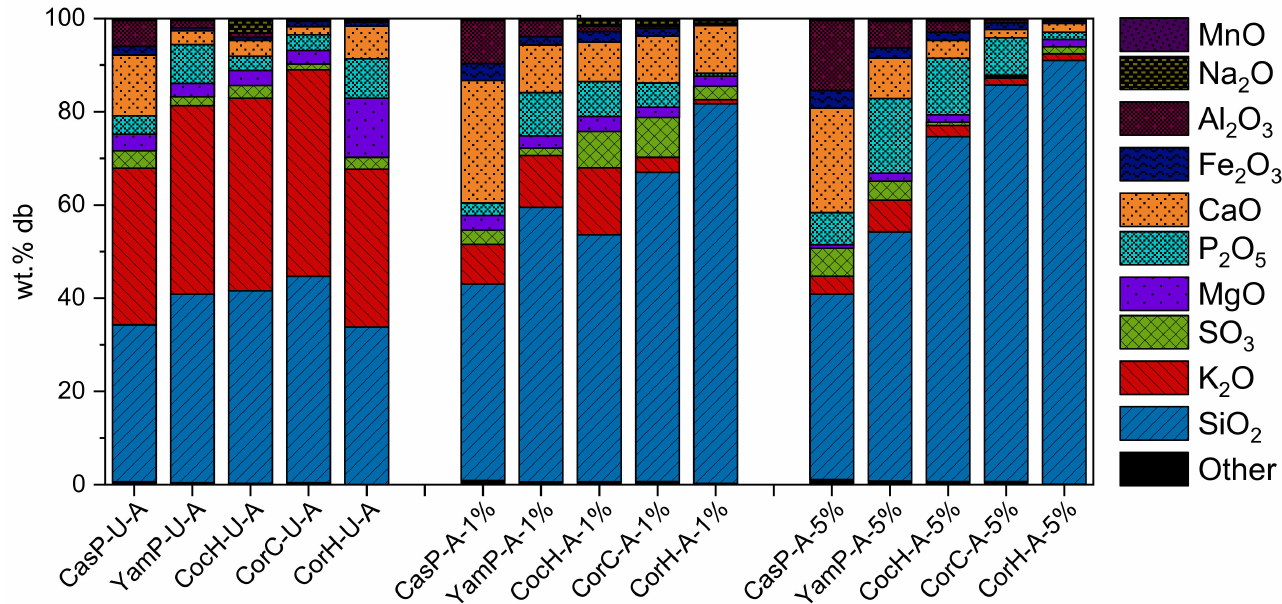
Figure 4. Chemical composition of the inorganic fraction (=100 wt.% db) of ashes obtained from the thermal treatment of the untreated and acid-leached samples with citric